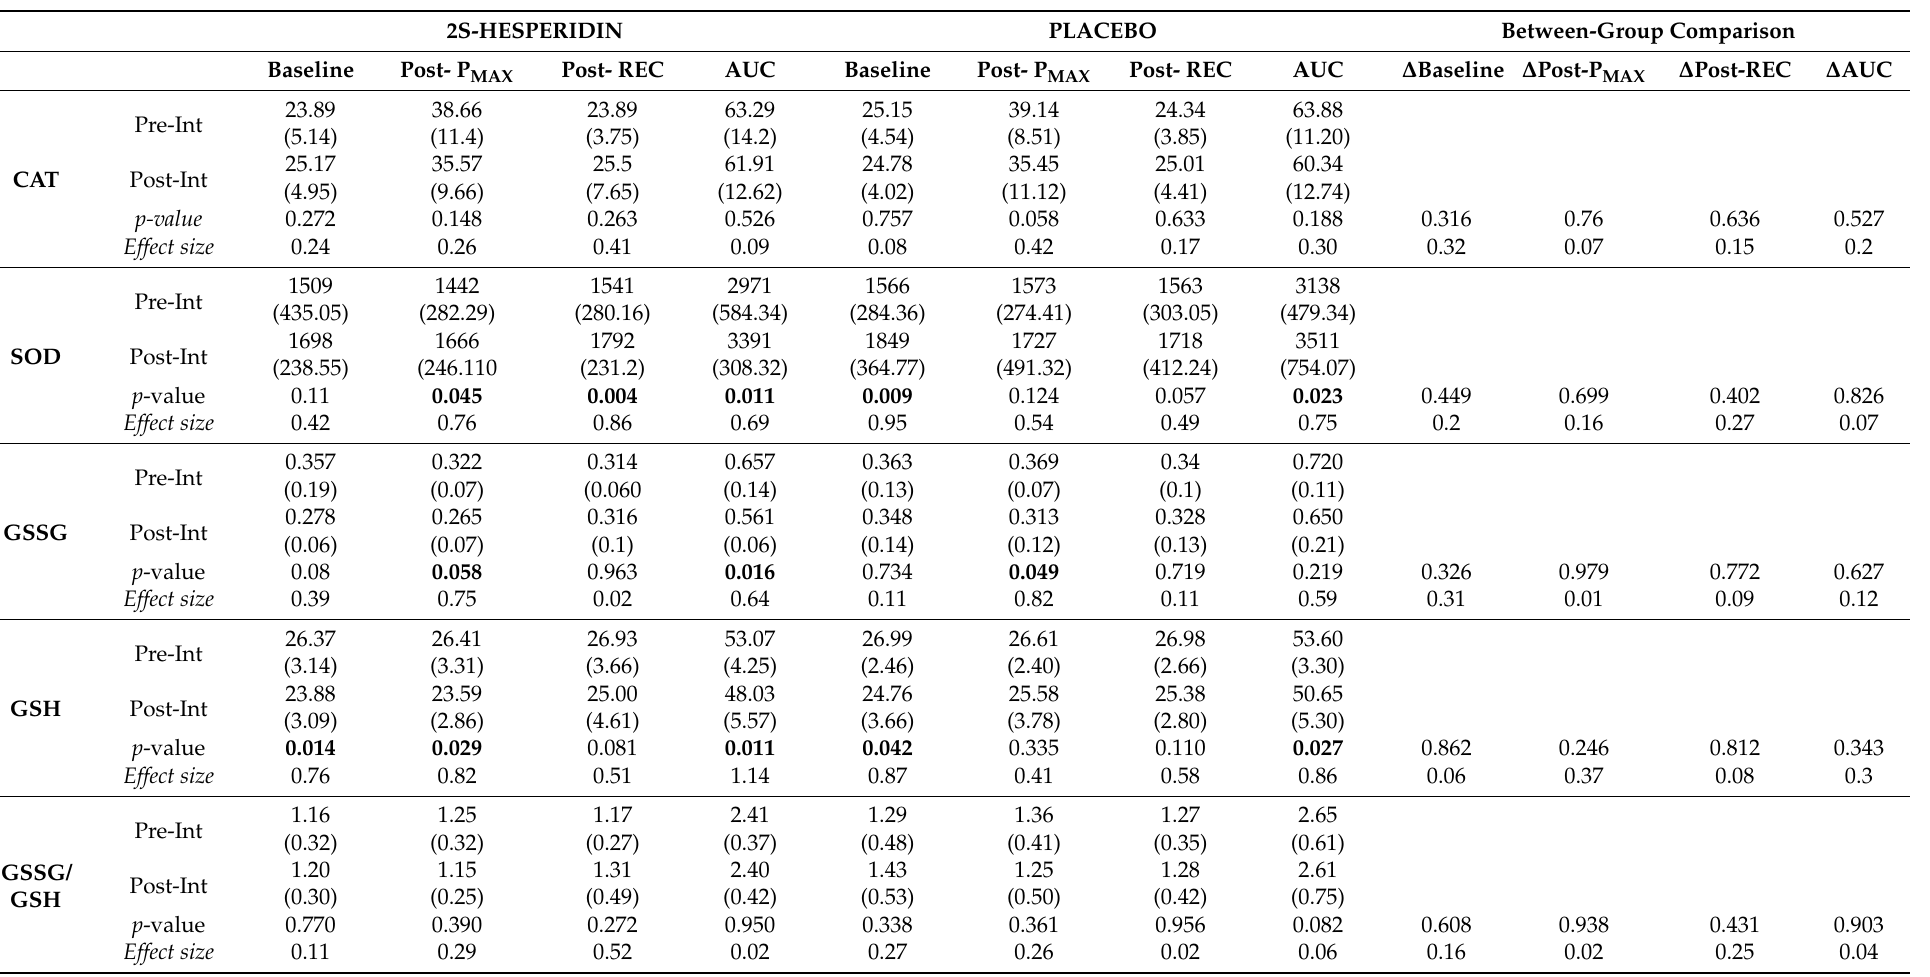
Table 3. Changes in enzymes and peptides endogenous antioxidants before, during and after rectangular test comparing pre- and